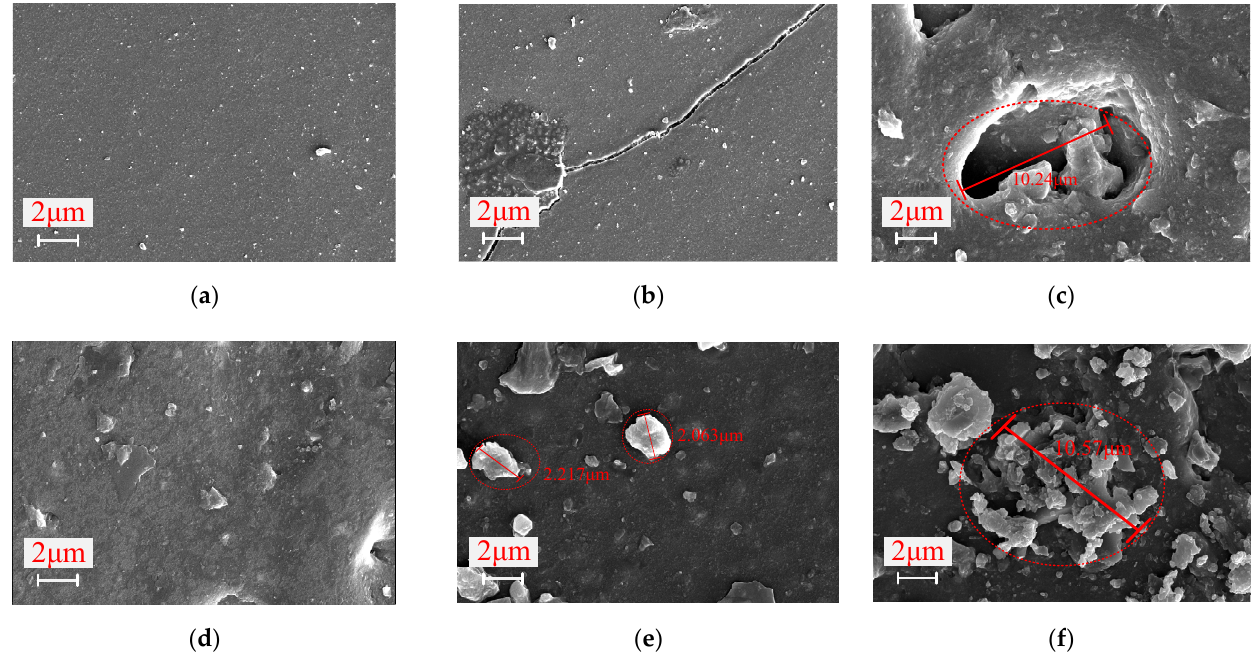
Figure 8. Scanning electron microscope results of the outer surface of the silicone rubber sheath: ( a ) S-unaged; ( b ) S-1; ( c ) S-2; ( d ) T-unaged; ( e ) T-1; ( f ) T-2. ( a ) S-unaged; ( b ) S-1; ( c ) S-2; ( d ) T-unaged; ( e ) T-1; ( f )